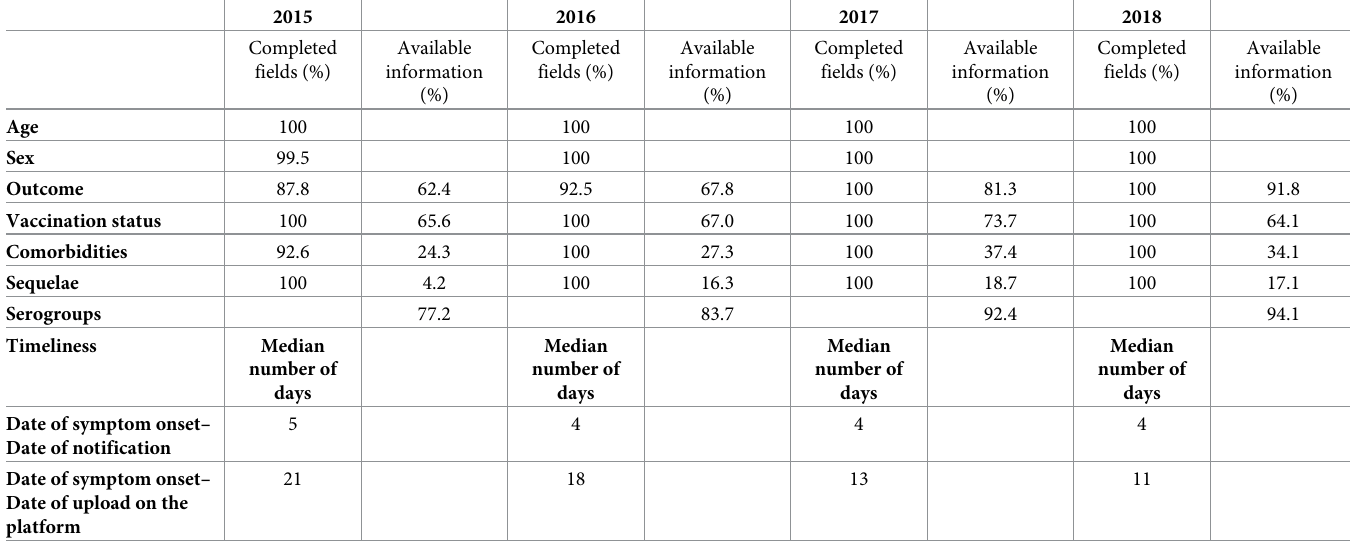
Table 2. Summary of the completeness and timeliness of selected variables included in the surveillance of invasive meningococcal disease in Italy, 2015–2017.